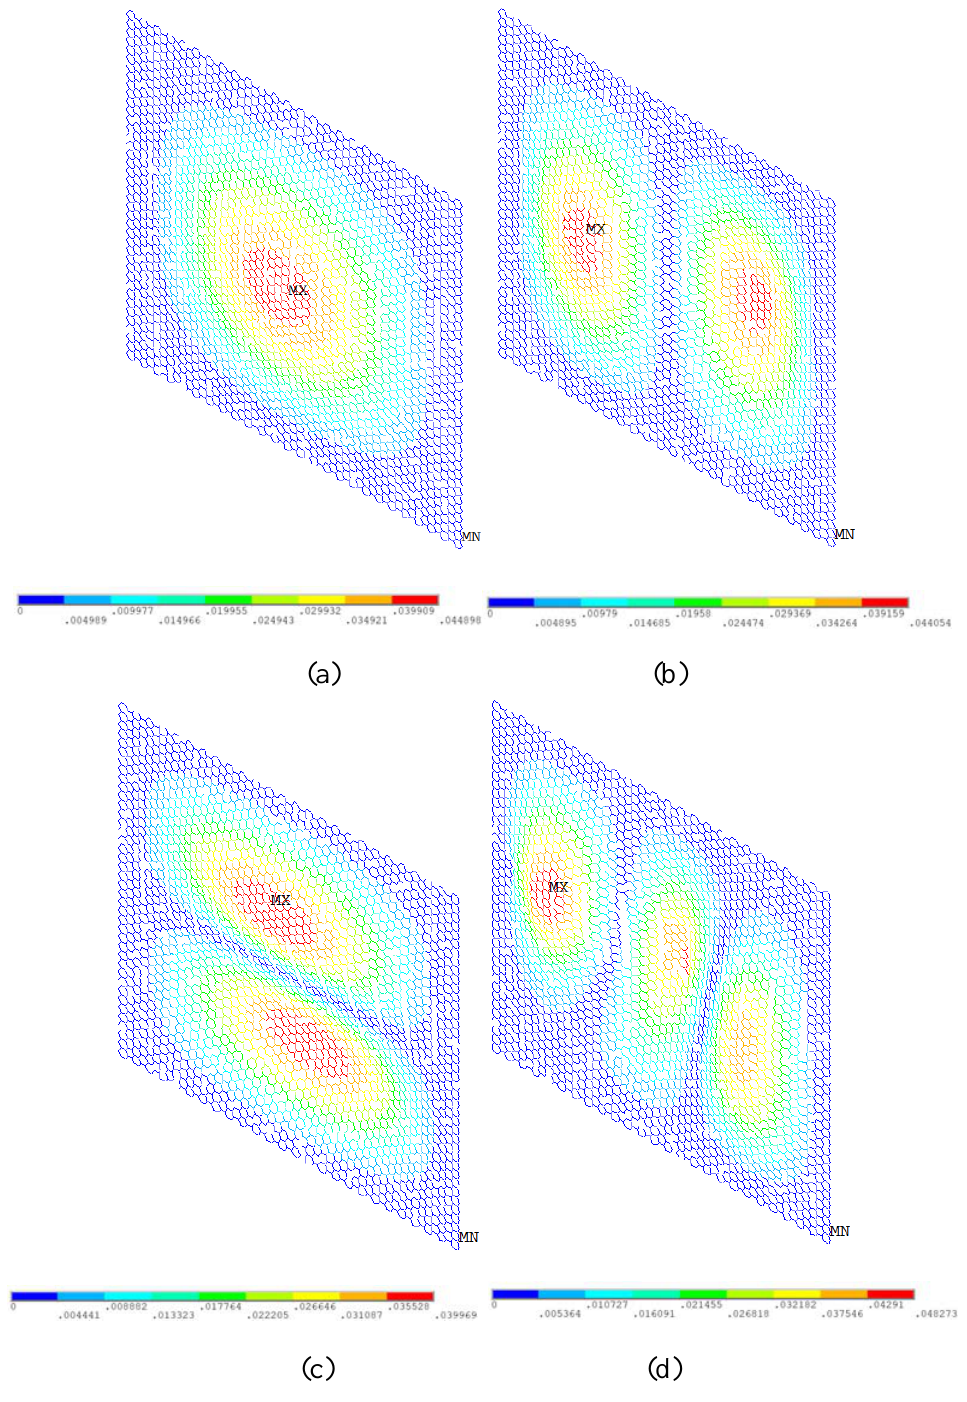
Figure 11. Displacement vector sum for graphene with 5% vacancy defects ( a – d show the first order, second order, third order, and fourth order of vibration mode, respectively).